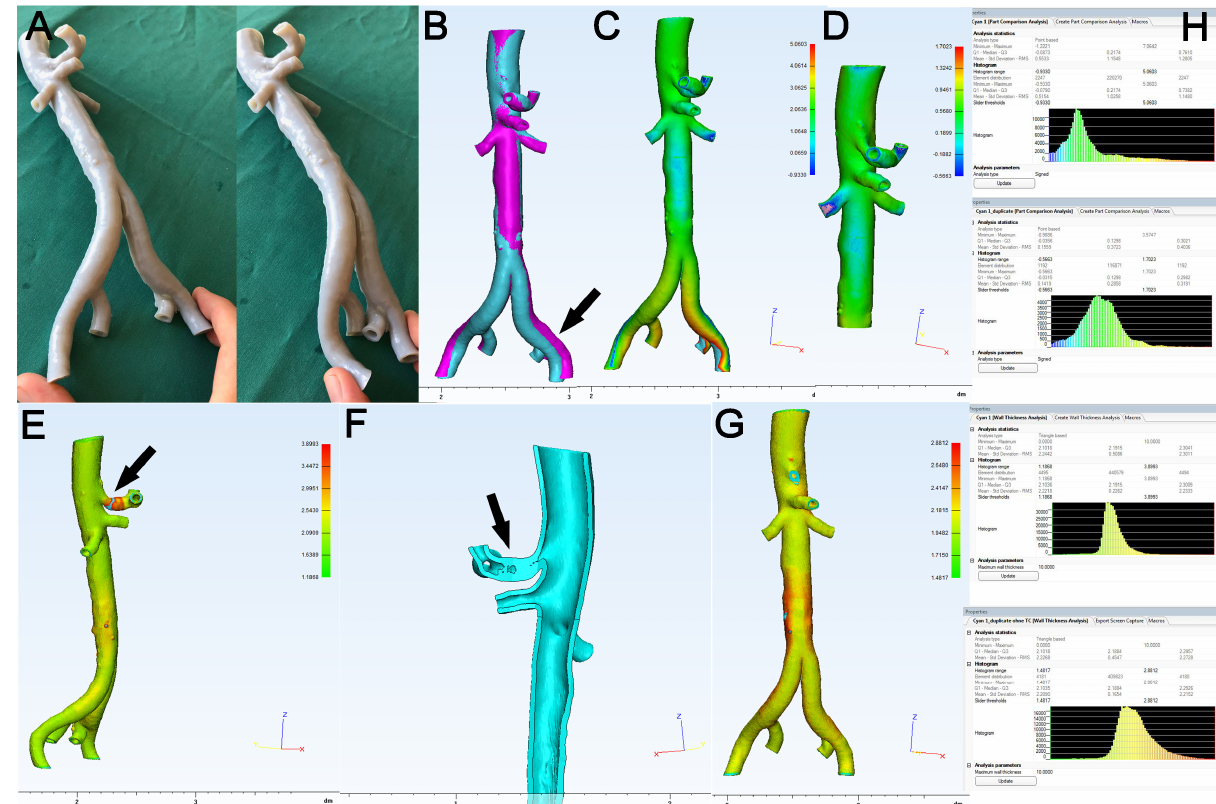
Figure 9. Representative depiction of artifact analysis. ( A ): Demonstration of flexibility of 3D model of abdominal aorta (Stratasys Tango ® gray). ( B ): Overlay of source STL (fuchsia) and 3D model STL (cyan) shows considerable surface deviation at left iliac axis (arrow). ( C ): PCA confirms hotspot at left iliac axis and mean deviation of 0.51 mm (( H ), upper panel). ( D ): After removal of distal aorta, PCA shows uniform color map and mean deviation decreased to 0.14 mm (( H ), upper middle panel). ( E ): Color map of WTA of abdominal aorta shows hotspot at the celiac trunk (arrow) caused by intraluminal remainders of support material in this hard-to-reach area, ( F ): anterior-posterior section (arrow). ( G ): For testing purposes, the celiac trunk was removed from the model and ( H ): mean wall thickness decreased from 2.22 to 2.20 mm (lower middle and lower